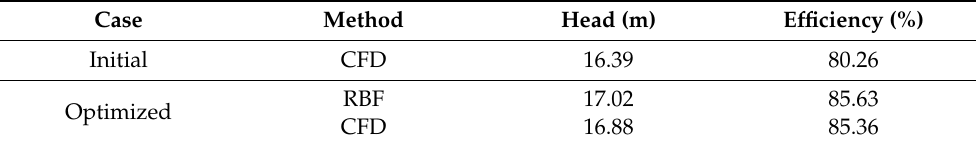
Table 6. Comparison of performance under design